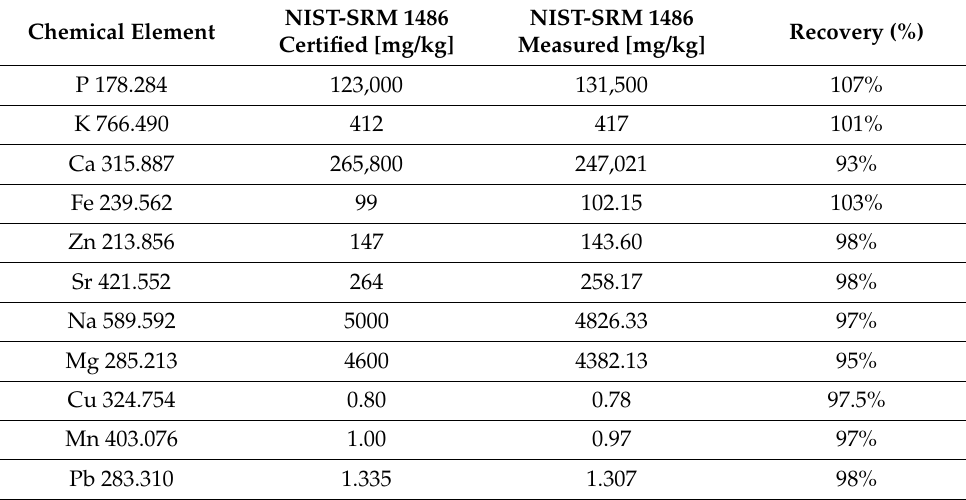
Table 5. Analysis of reference material Bone Meal NIST-SRM 1486 using